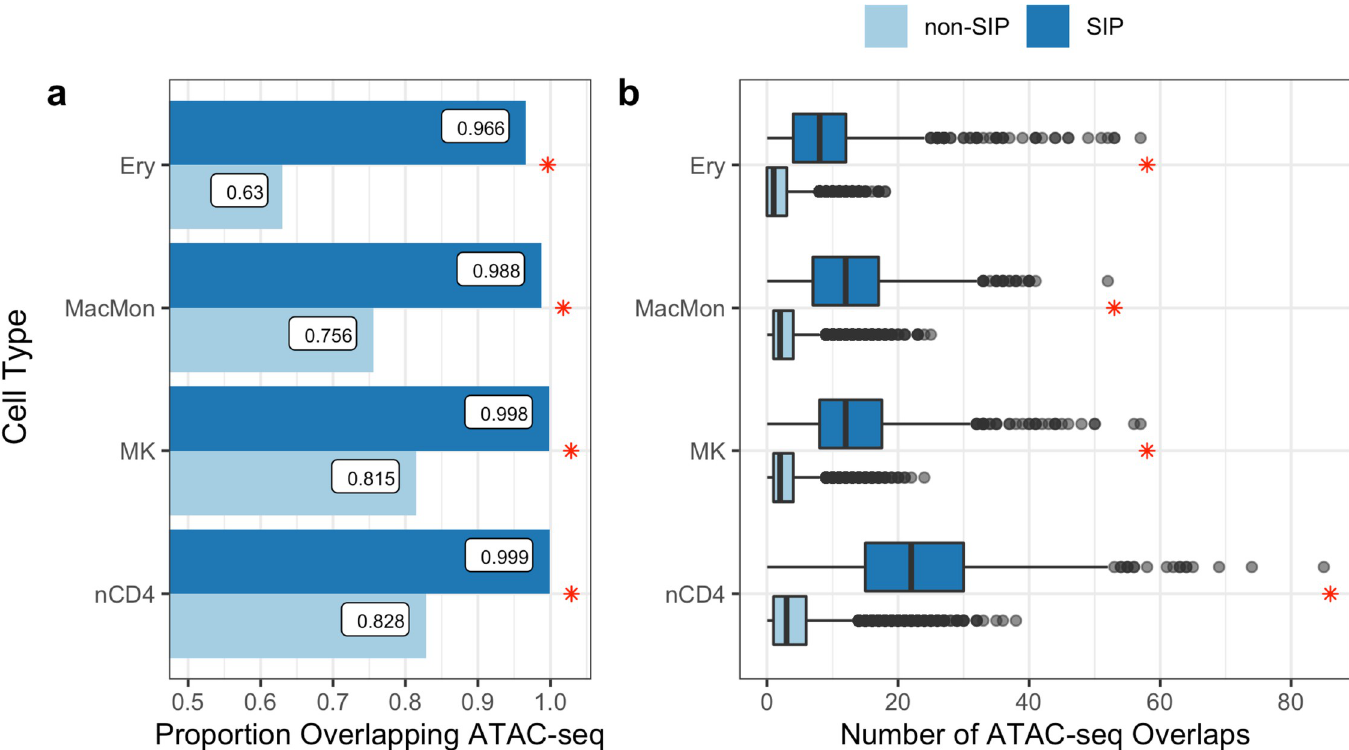
Fig 3. SIP PIRs overlap with ATAC-seq peaks. (A) In each cell type, the proportion of SIP having at least one PIR that overlaps a cell type-specific ATAC-seq peak is significantly greater than the proportion of non-SIP having at least one PIR that overlaps an ATAC-seq peak (the red asterisk ( � ) denotes Chi-square p -value < 2.2e-16). (B) The distribution of the number of PIRs overlapping with ATAC-seq peaks for each pcHi-C bait (y-axis) for each cell type (x-axis). In each cell type, significantly more SIP interactions overlap with ATAC-seq peaks compared to non-SIP interactions (the red asterisk ( � ) denotes two-sided t-test p -value < 1.2e-162). (Ery = erythrocytes; MacMon = macrophages/monocytes; MK = megakaryocytes; nCD4 = naive CD4 T-cells; Neu = neutrophils).